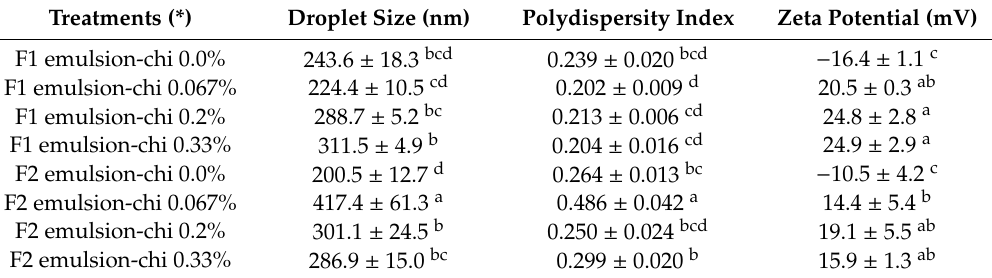
Table 2. Droplet size, polydispersity index, and zeta potential of